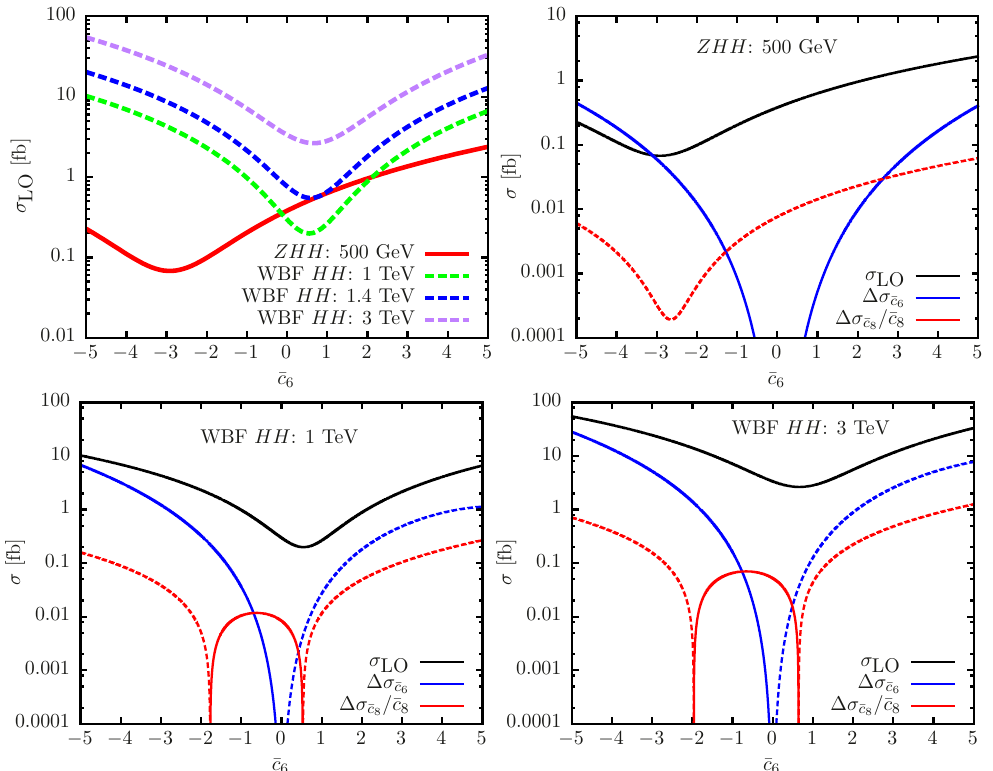
Figure 6 . Top-left plot: (cid:22) c 6 dependence of the LO cross section for ZHH and WBF HH at di(cid:11)erent energies. The three other plots show the (cid:22) c 6 dependence of (cid:1) (cid:27) (cid:22) c (cid:27) LO for ZHH production at 500 GeV (top-right), and WBF HH at 1000 GeV (bottom-left) and 3000 GeV (bottom-right). Negative values are displayed as short-dashed